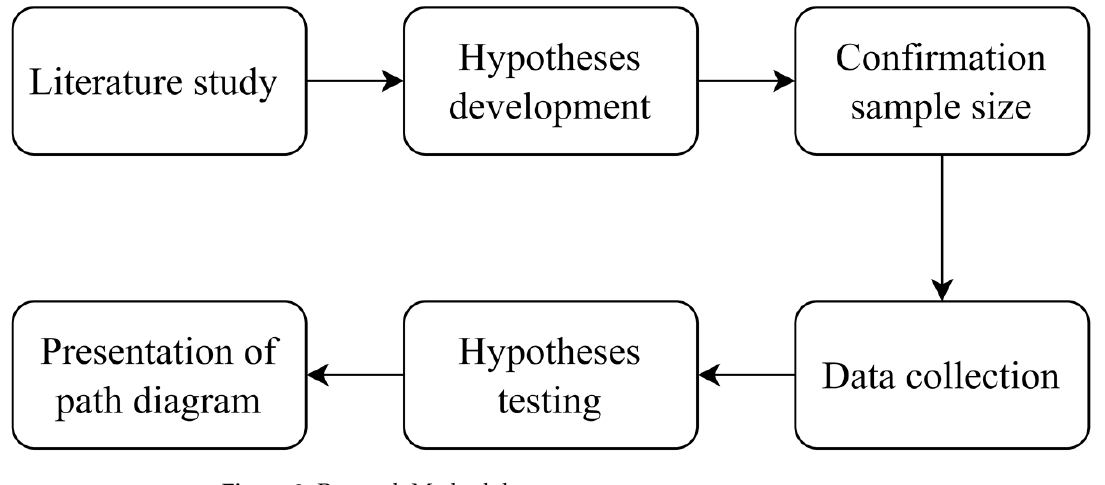
Figure 3. Research Figure 3. Research Methodology .